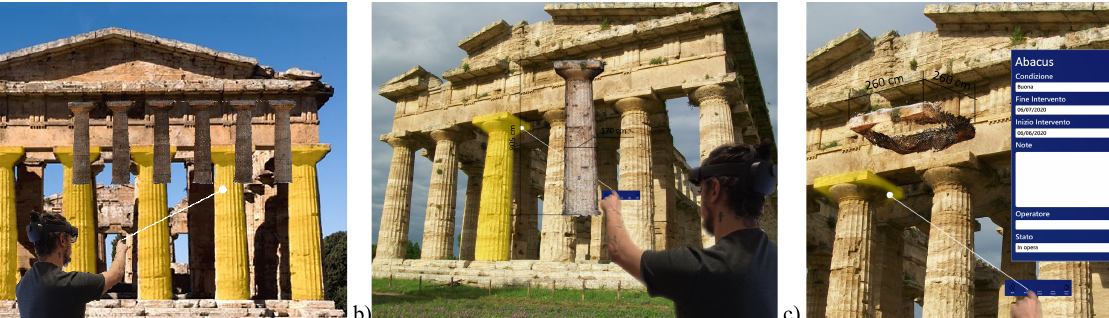
Figure 4. MR access to the first level of classification of the Neptune temple in Paestum (a). Selection of the class “column” (b) and virtual interaction with the sub-elements abacus and associated textual information